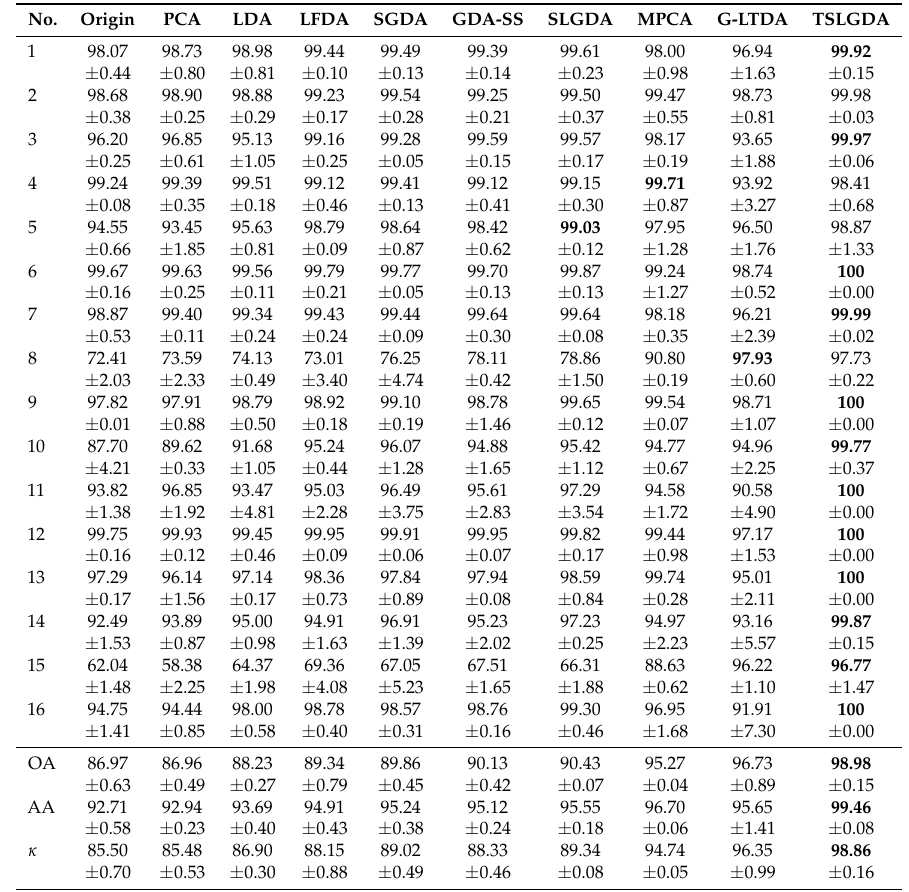
Table 5. Classification accuracy (%) and standard deviation of different methods for the Salinas data when the reduced dimension is